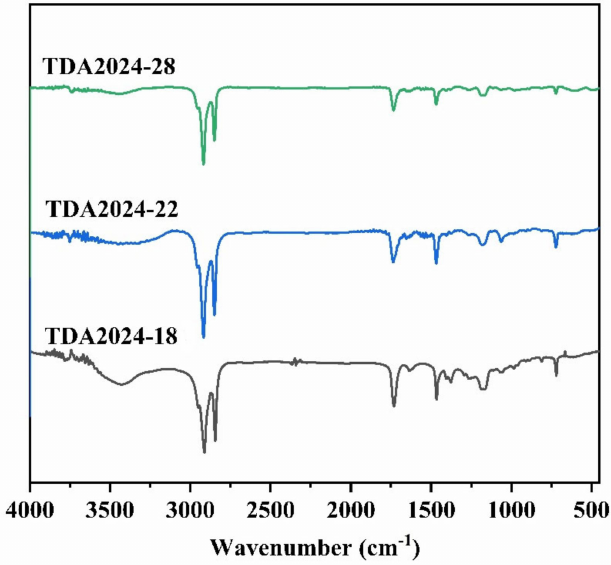
Figure 2. FT-IR spectra of the α -olefins/ultra-long alkyl acrylate bipolymers. 1 H NMR spectra of the three bipolymers are shown in Figure 3. The peak at 0.8 ppm is attributed to the protons in the methyl group. Peaks ranging from 0.9–1.5 ppm is from the protons in methylene group. Besides, the peak at 4.0 ppm was due to the proton adjacent to the oxygen atom (-OCH 2 ) in methylene group. The peak at 7.26 ppm was due to the CDCl 3 deuterated